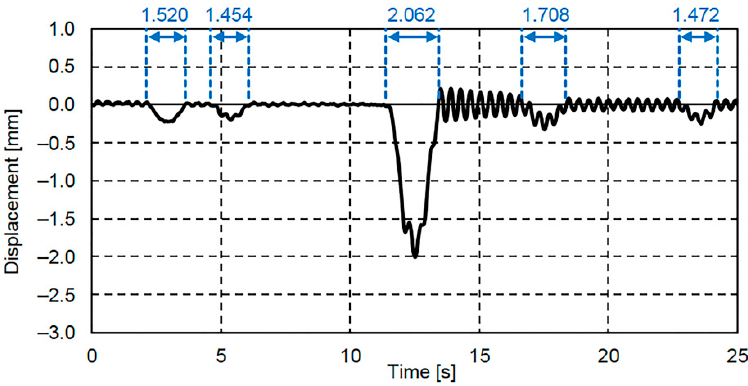
Figure 7. Displacement response obtained using the contact displacement gauge at G4.